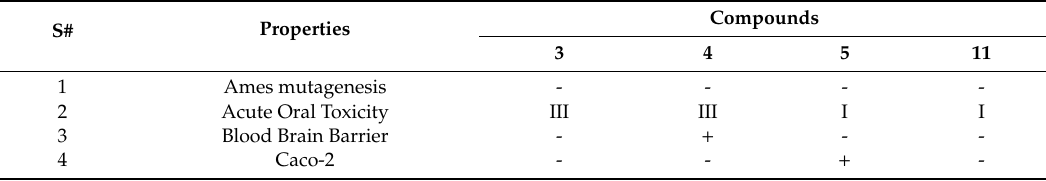
Table 4. Absorption, distribution, metabolism, excretion and toxicity (ADEMT) properties of Compounds 3 – 5 and